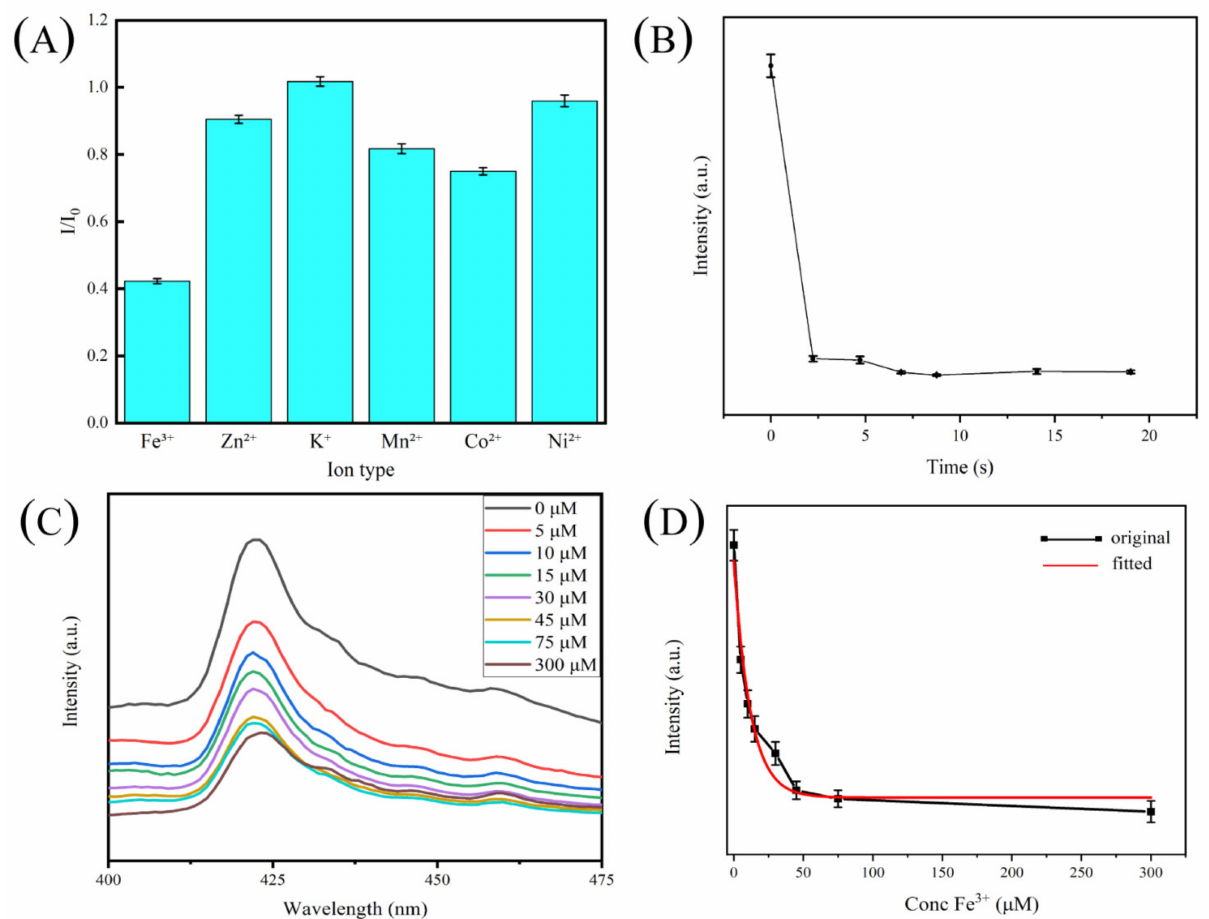
Figure 7. Effects of different ions on fluorescence intensity of CAHG ( A ); quenching effect of Fe 3+ on CAHG at different time ( B ); fluorescence spectra of CAHG with the presence of increasing amount of Fe 3+ anion ( C ); variation curve of fluorescence intensity with Fe 3+ concentration ( D